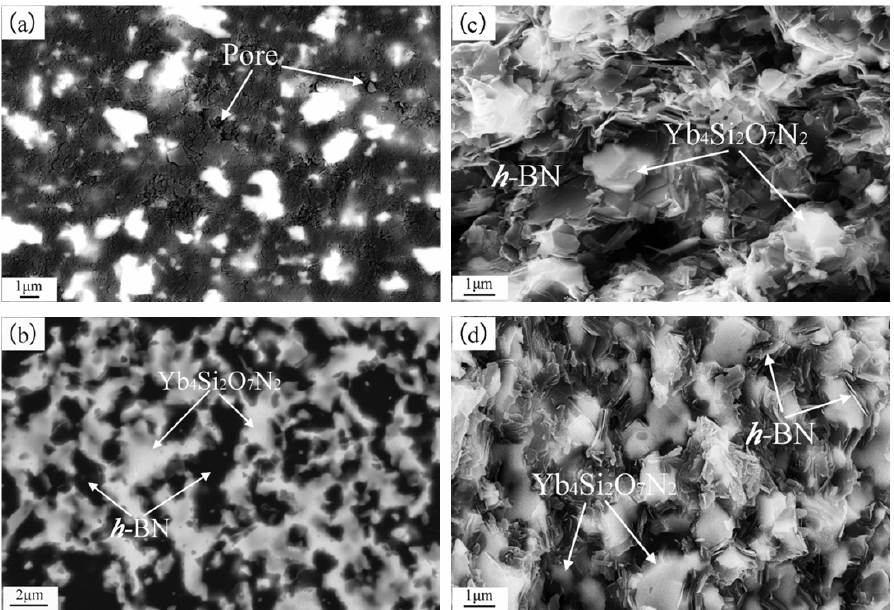
Fig. 2 Backscattered electron images of polished surfaces and secondary electron morphologies of fracture surfaces: (a, c) BYb20, (b, d)